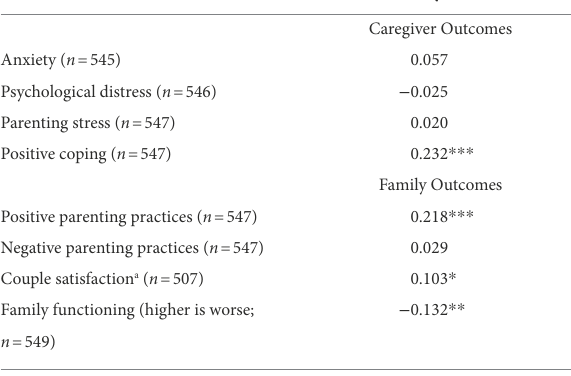
TABLE 4 Correlations between the Family PACS and caregiver and family